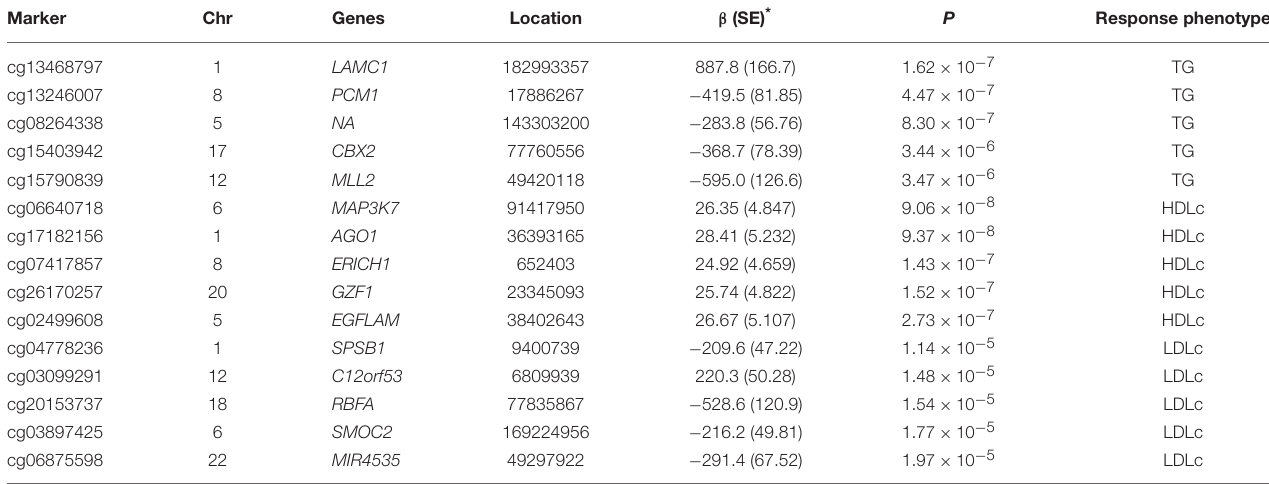
TABLE 2 | Top five CpGs for each lipid showing change in DNA methylation for change in TG, HDLc, and LDLc profiles in the GOLDN study ( n = 443 ) after 3 weeks of daily fenofibrate (160 mg). Marker Chr Genes Location β (SE) *